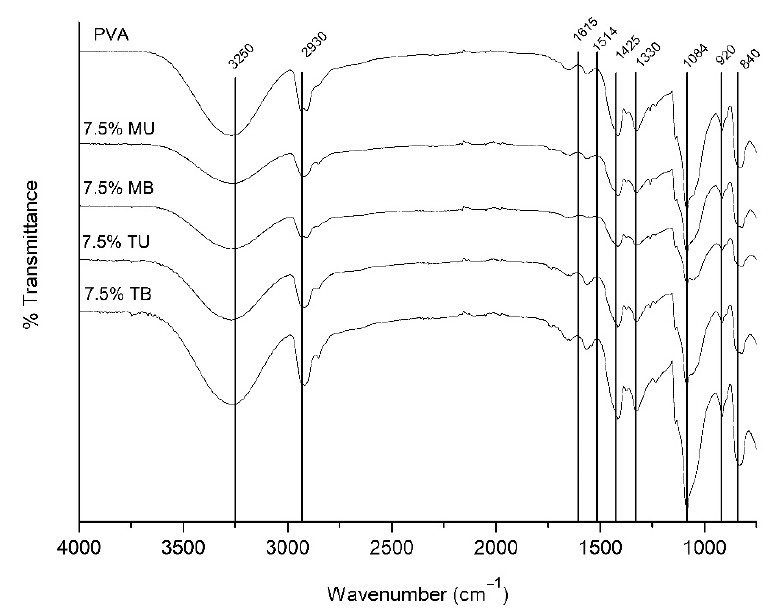
Figure 2. ATR-FTIR spectra of pure PVA and PVA-(L)CNF films (PVA containing 7.5% of mechanical unbleached nanocellulose (7.5% MU), PVA containing 7.5% of mechanical bleached nanocellulose (7.5% MB), PVA containing 7.5% of TEMPO unbleached nanocellulose (7.5% TU) and PVA containing 7.5% of TEMPO bleached nanocellulose (7.5% TB)).